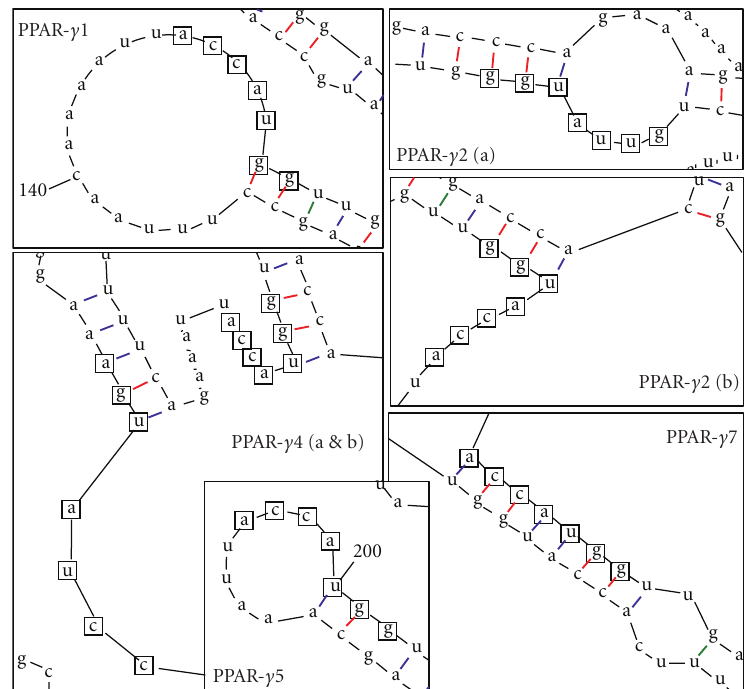
Figure 4: Magnified RNA folding Models. Full-length PPAR- γ splice variants were folded using the mfold software. The start codon regions for each isoform are magnified here to show the canonical start codon region (accAUGg) and the number of bases in that region that are